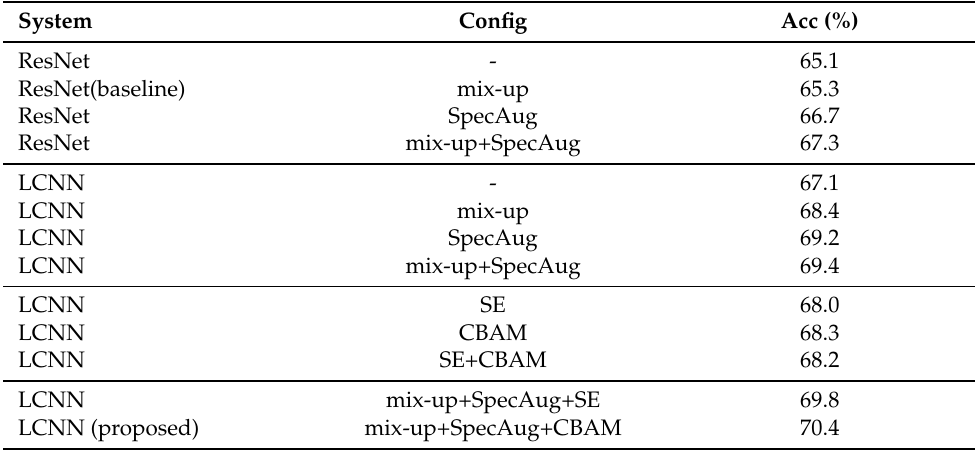
Table 3. Effect of LCNN, data augmentation, and deep architecture